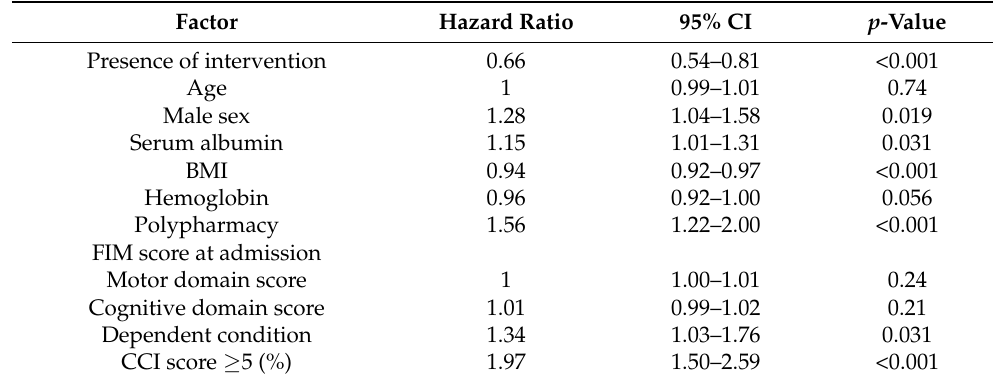
Figure 3. Kaplan–Meier curves showing the probability of non-readmission following discharge. Graphs are presented for the interprofessional collaboration intervention. Table 3. Results of the Cox hazards model based on the relationship between the readmission rates and intervention of